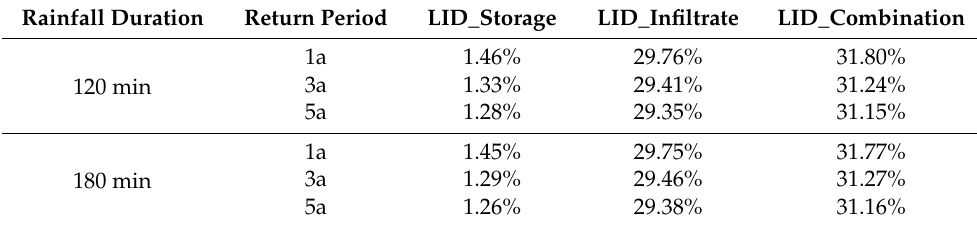
Table 10. Reduction rates of flood volume by various LID